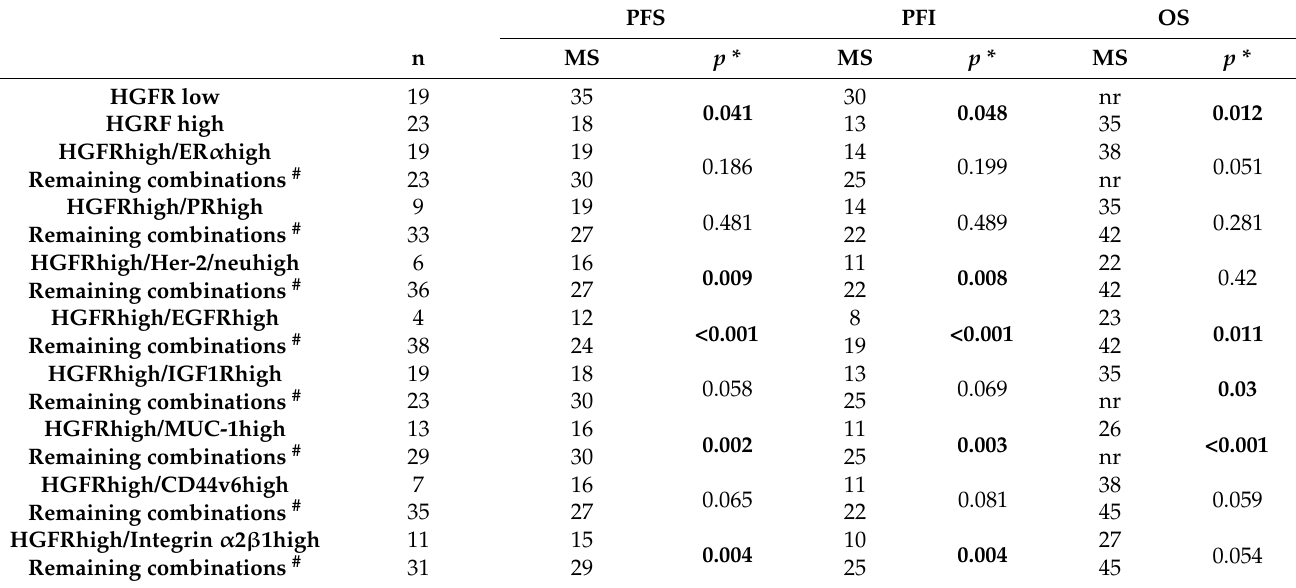
Table 5. Univariate survival analysis of dual expression of HGFR and other protein